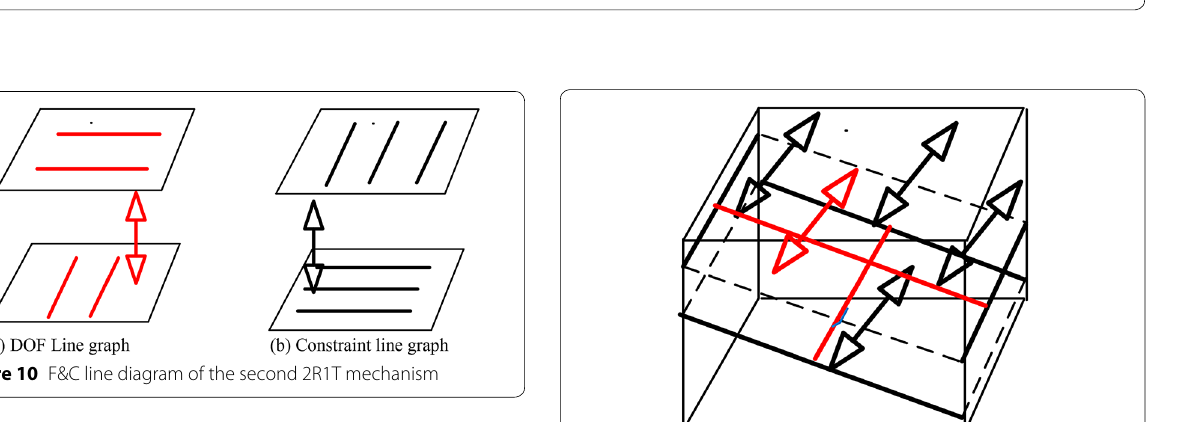
Figure 9 Correlated line diagram at general position